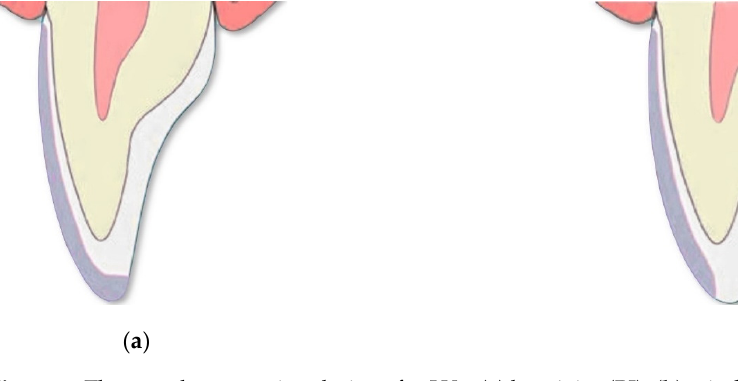
Figure 3. The tested preparation designs for LVs: ( a ) butt joint (BJ); ( b ) window (WI).